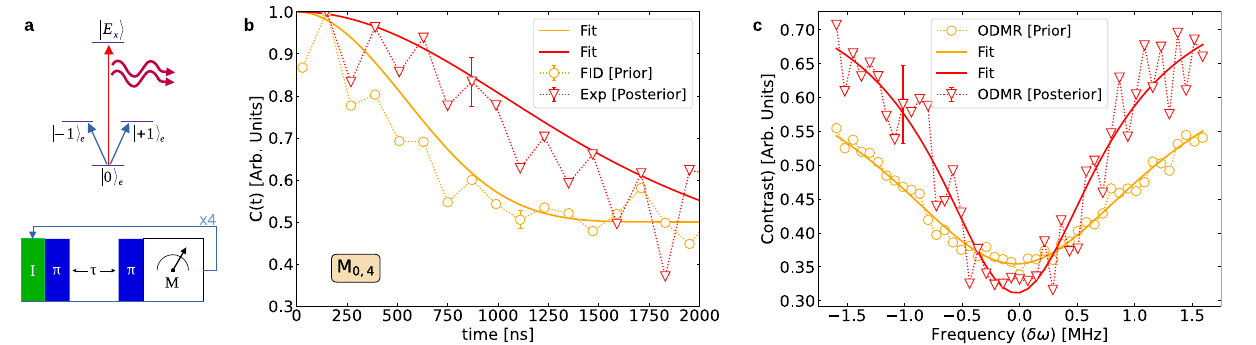
Fig. 2 | Probe FID before and after bath puri fi cation. a Energy-level diagram of corresponding conditional bath state is 4 times lower than the original (orange) the central probe-spin (qubit) depicting the basis states ( ∣ ±1 i , ∣ 0 i ) and the cycling decay rate indicating the AZEregime ofthe qubit. c The central ODMR peak of the (cid:2) usedforreadout. transitionbetweenthegroundstate ∣ 0 i andtheexcitedstate ∣ E x probespinre fl ectingthemodi fi cationoftheinitialspin – bathspectrum(orange)to Shown below is the pulse sequence for four measurements. b Experimental and a narrow single peak and after (red) the conditional measurement sequence, CT theoretical FID of the probe spin before (orange) and after (red) four measure- M 0,4 infullagreementwiththemeasuredandcalculatedFIDin( b ).Thesolidlines fi t ments with identical (0) results (CT M 0,4 ). The effective FID rate of the the experimental data and were not obtained from theoretical